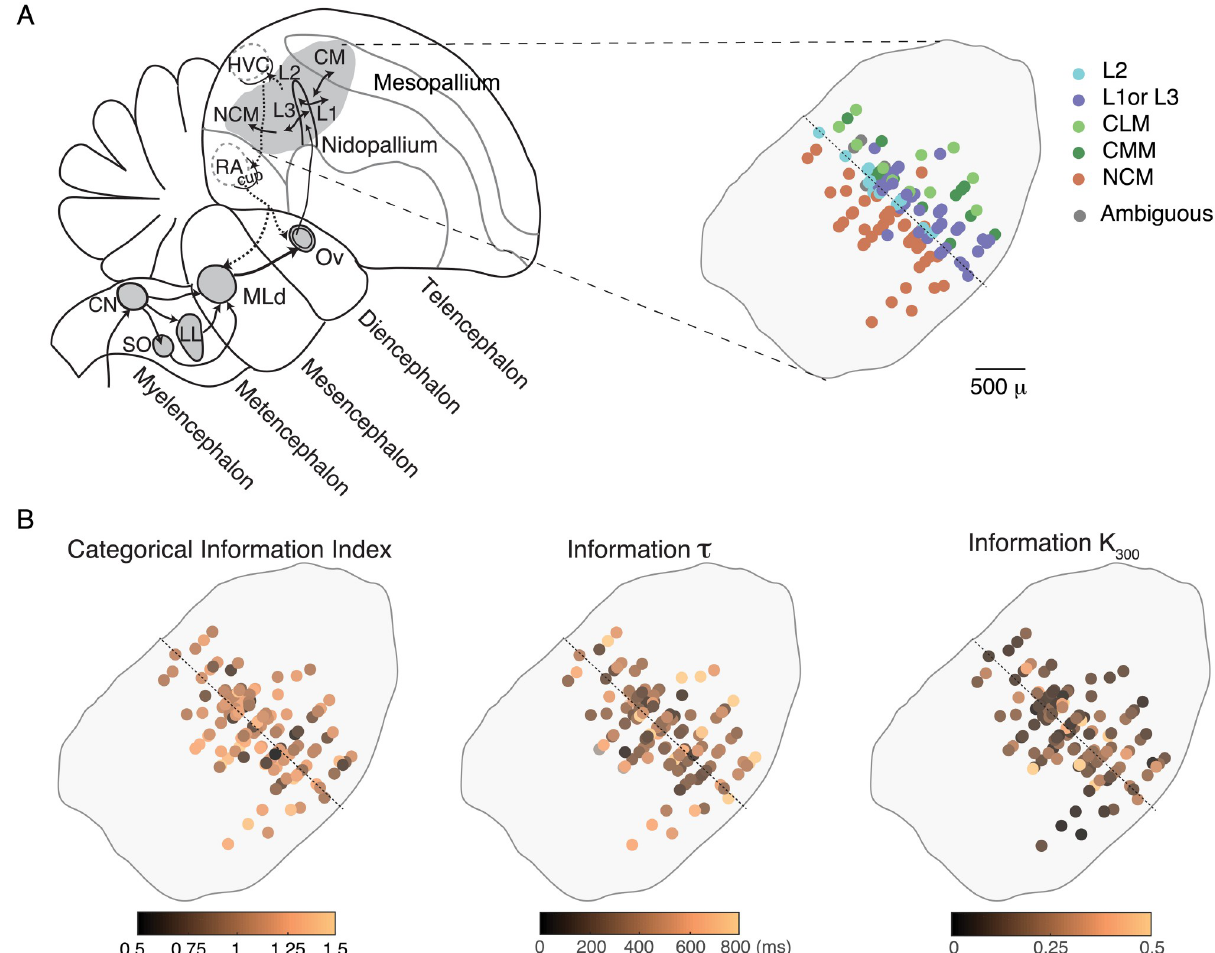
Fig 10. Anatomical organization. A . The left panel is a schematic of the different processing stages in the ascending avian auditory system (grey areas) shown on a parasagittal view (the feedfoward pathways are in solid arrows, the feedback connections are in dotted arrows and motor areas are delineated by grey dotted lines). Our recording sites were from the primary and secondary avian auditory cortical areas (the auditory pallium) and are shown on the right panel. The recording sites from different birds were aligned in the rostral-caudal dimension using the oblique rostro-caudal long axis of L2 (dotted line). Recording site positions also varied along the medial-lateral dimension (in and out of the page) and are all superimposed here. Abbreviations: CN, cochlear nucleus; SO, superior olive; LL, lateral lemniscus; MLd, dorsolateral nucleus of the mesencephalon; Ov, nucleus ovoidalis; RA, robust nucleus of the arcopallium; HVC, used as a proper name; NCM, caudomedial nidopallium; CM, caudal mesopallium. B . Functional anatomical maps of the Categorical Information Index, the time constant τ and the relative value at 300ms k 300 of the cumulative information for stimuli for all single units with anatomical data (303/337 neurons). Each site is colored according to the value(s) of the variable being displayed. Transparency is used to reveal overlapping sites in this view as well as, potentially, combination of single units that were recorded from the same electrode and site.